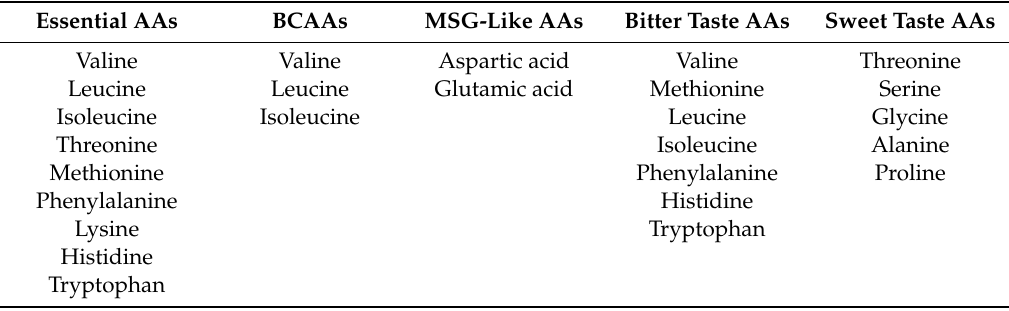
Table 1. Groups of amino acids studied. AA: amino acids; BCAA: branched-chain AAs; MSG: monosodium